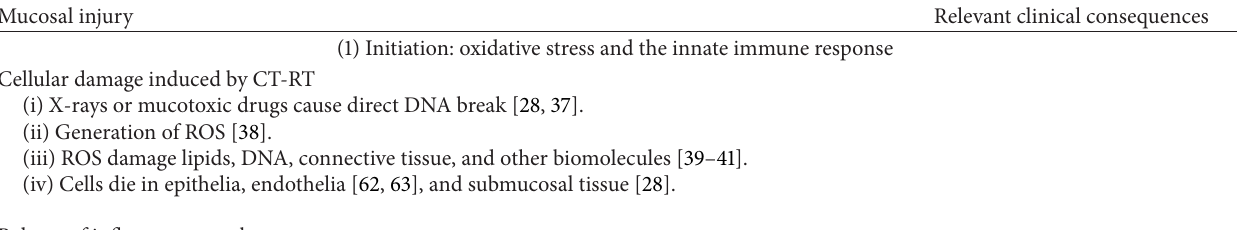
Table 1: Local and systemic pathogenesis and consequences of regimen-induced inflammatory